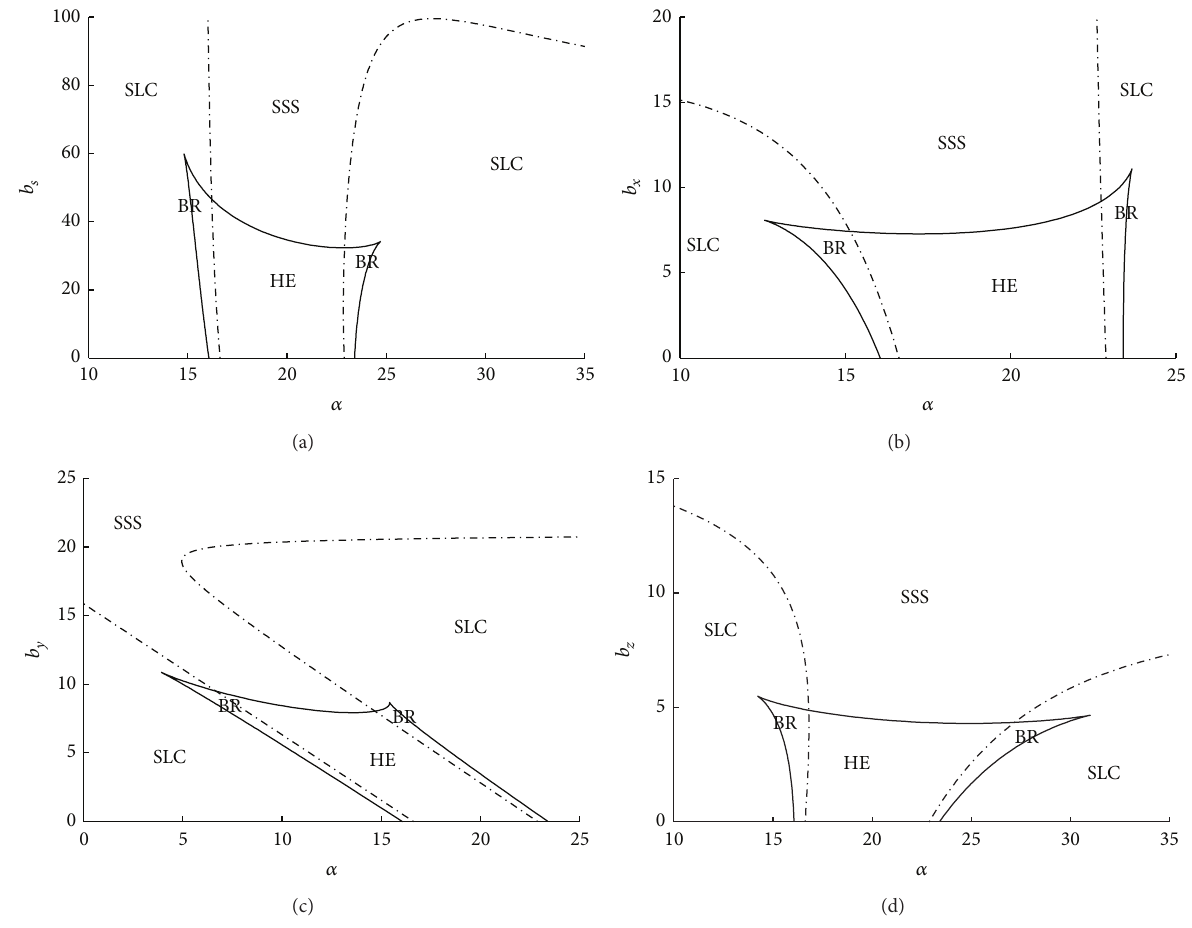
Figure 9: Bifurcation diagram of parameter 𝛼 versus parameters 𝑏 𝑠 , 𝑏 𝑥 , 𝑏 𝑦 , and 𝑏 𝑧 for model (2).